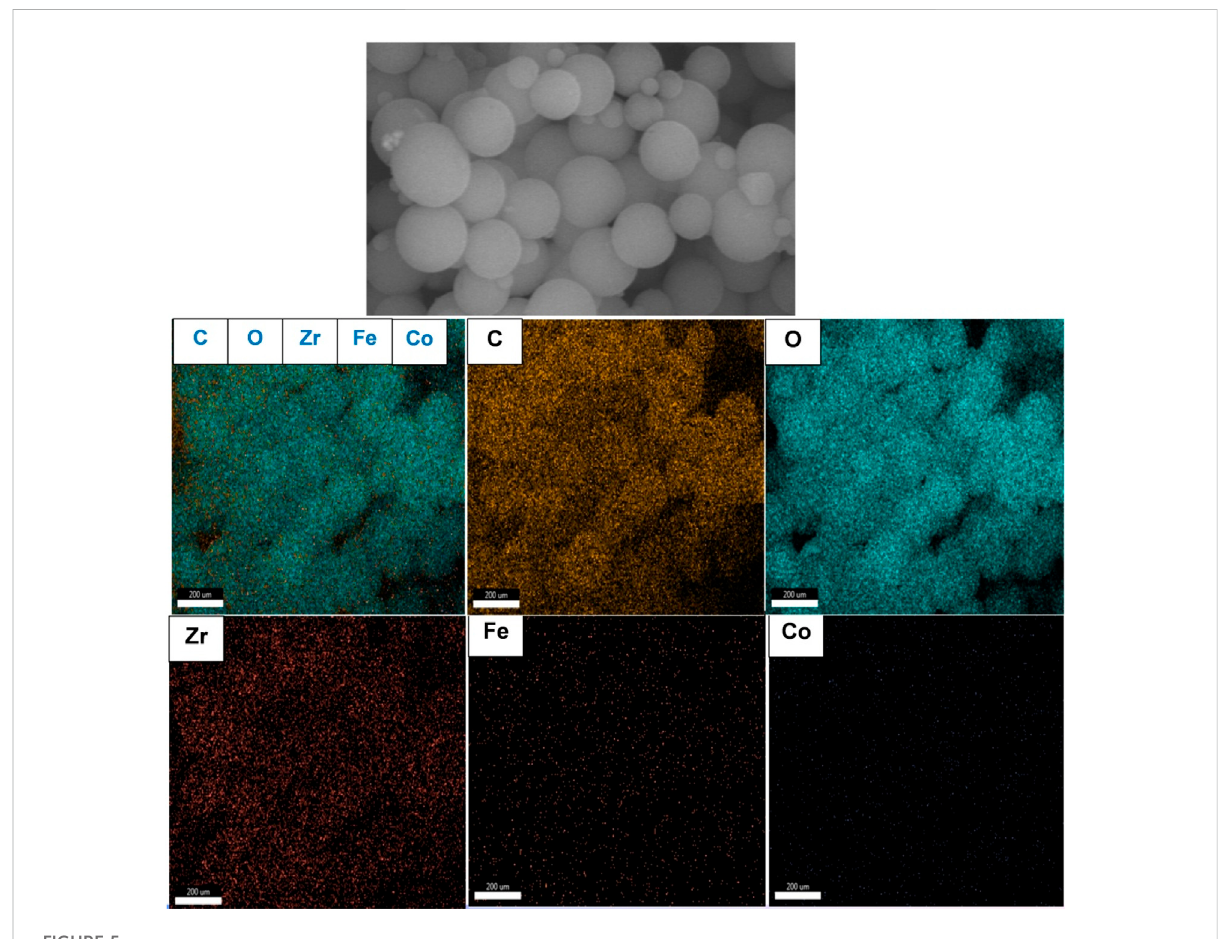
FIGURE 5 SEM-EDS elemental mapping of CoFe 2 O 4 @UiO-66